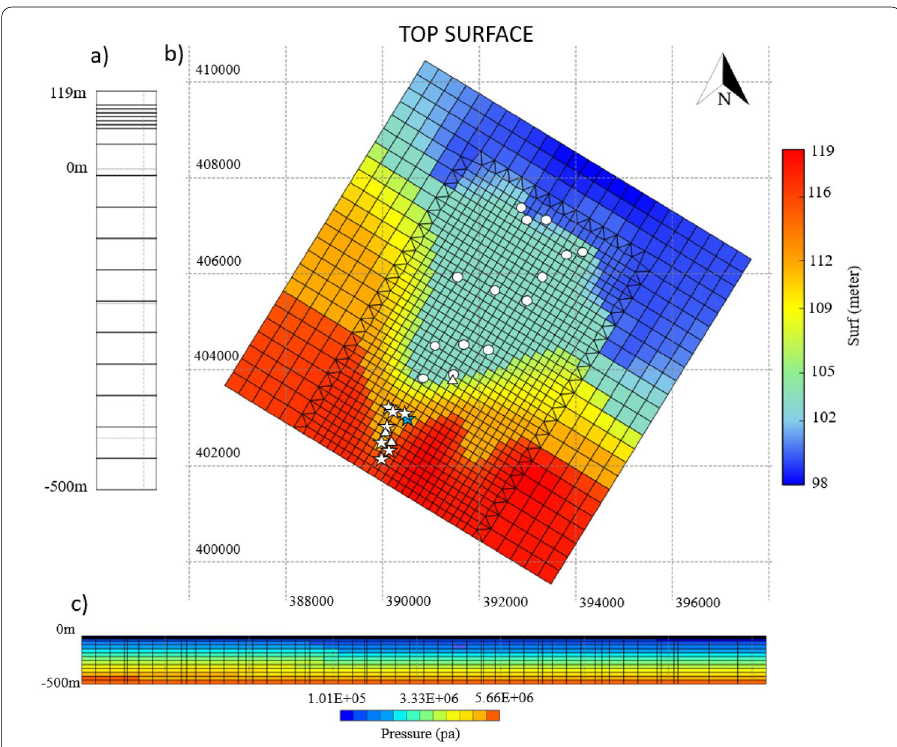
Fig. 4 Grid refined and optimized with PyTOUGH visualized in TIM. a Layer structure of the model. b Elevation of the top surface of the model, corresponding to the groundwater table. White points are monitoring points and white stars are the injection wells. c Cross section showing the initial pressure